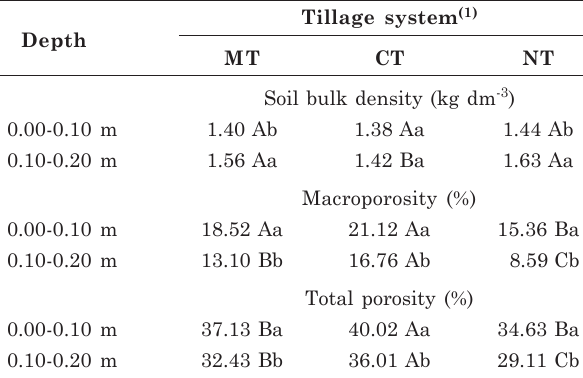
Table 1. Soil bulk density, macroporosity, and total porosity in accordance with the treatments and depths sampled